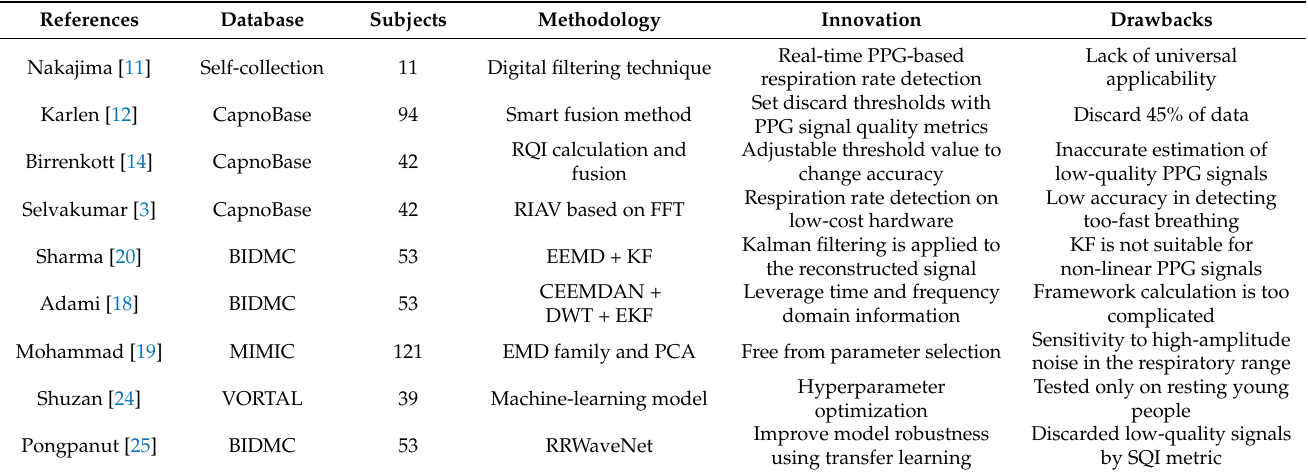
Table 1. A literature review of respiratory rate detection based on PPG.